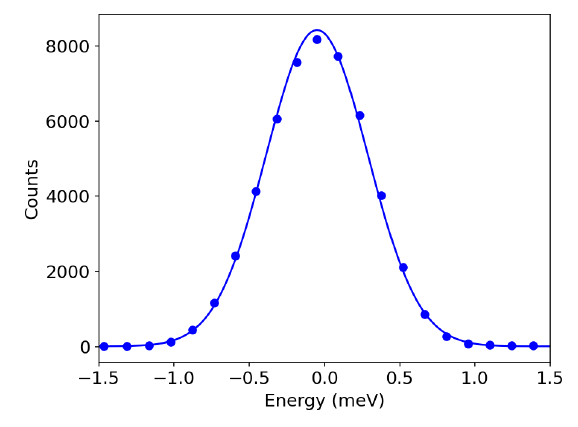
Figure 3. Line shape of the elastic scattering from a vanadium sample at T = 10 K and an incoming neutron energy of 15 meV. The line is a fit by a Gaussian plus a flat background.